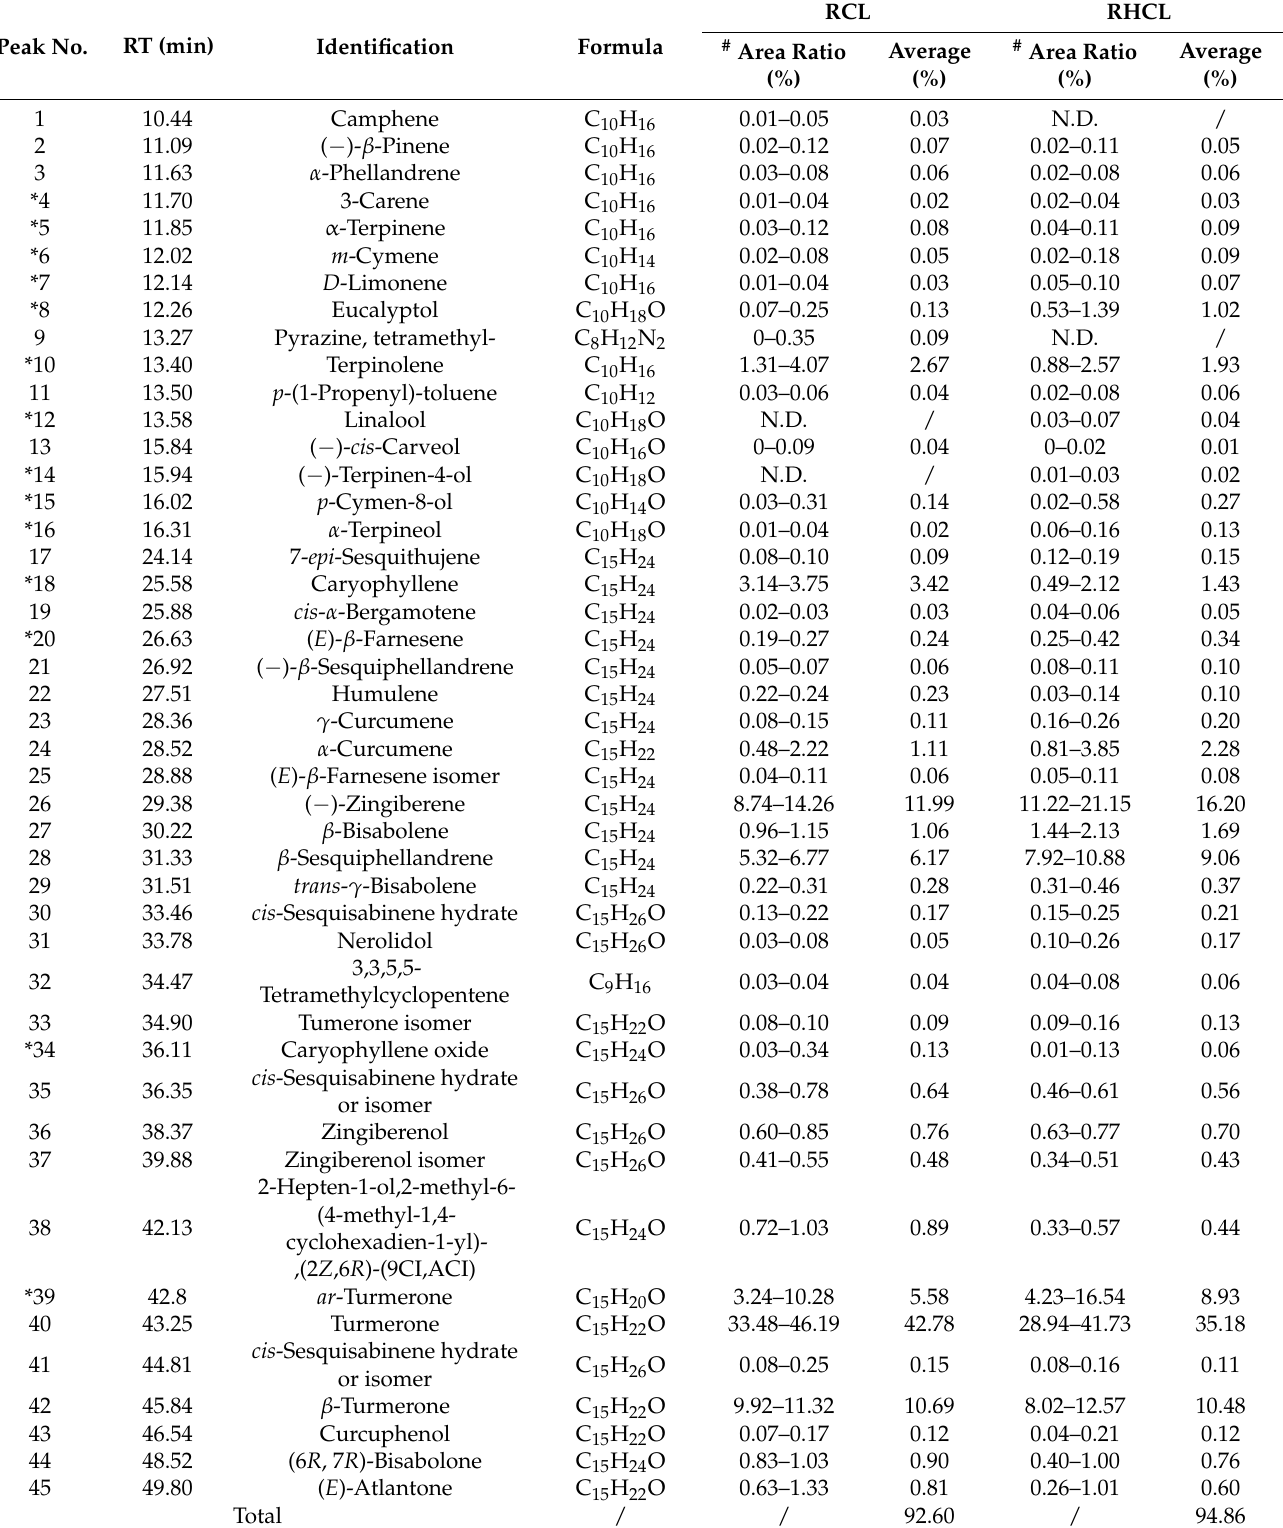
Table 1. Chemical constituents in RCL and RHCL volatile oils were identified by